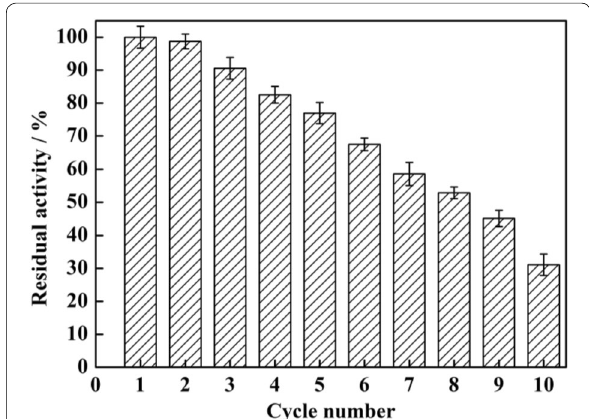
Fig. 7 Reusability of the co-immobilized laccase and TEMPO. The co-immobilized nanoparticles retained above 50% residual activity after 8 cycles of